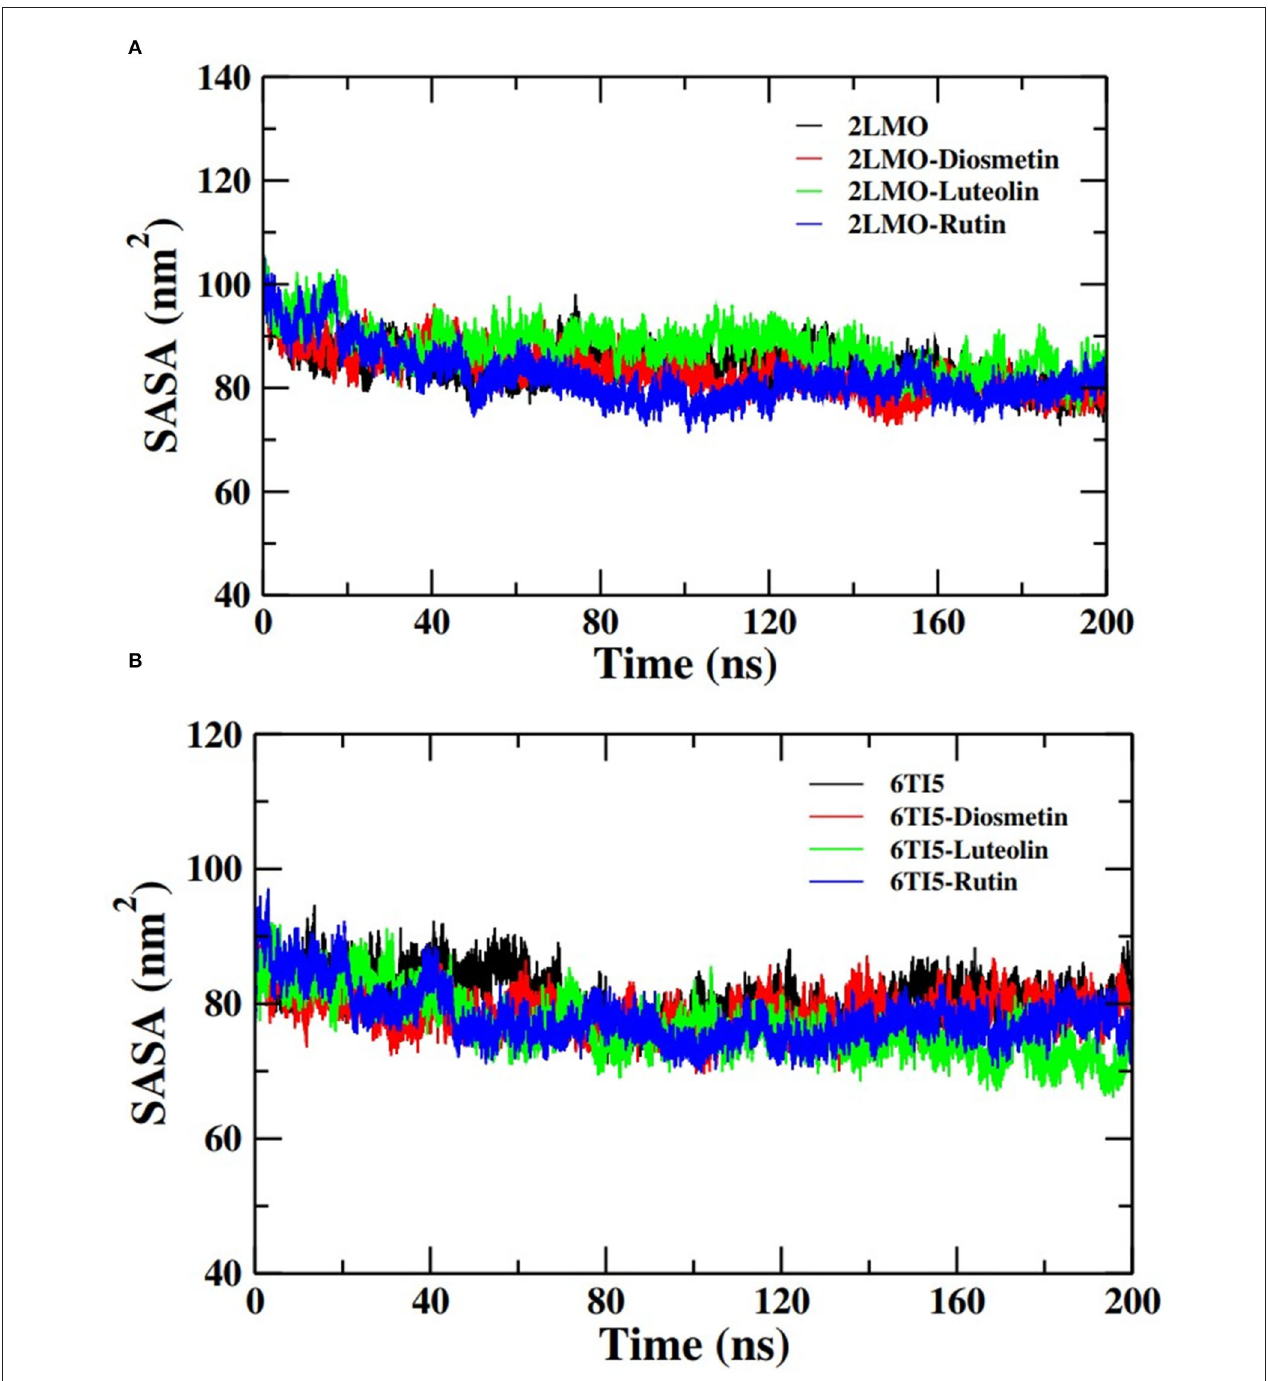
FIGURE 5 | Solvent accessible surface area (SASA) of (A) 2LMO and its complexes with Diosmetin, Luteolin and Rutin and (B) 6TI5 and its complexes with Diosmetin, Luteolin and Rutin over the course of 200 ns of simulation time.